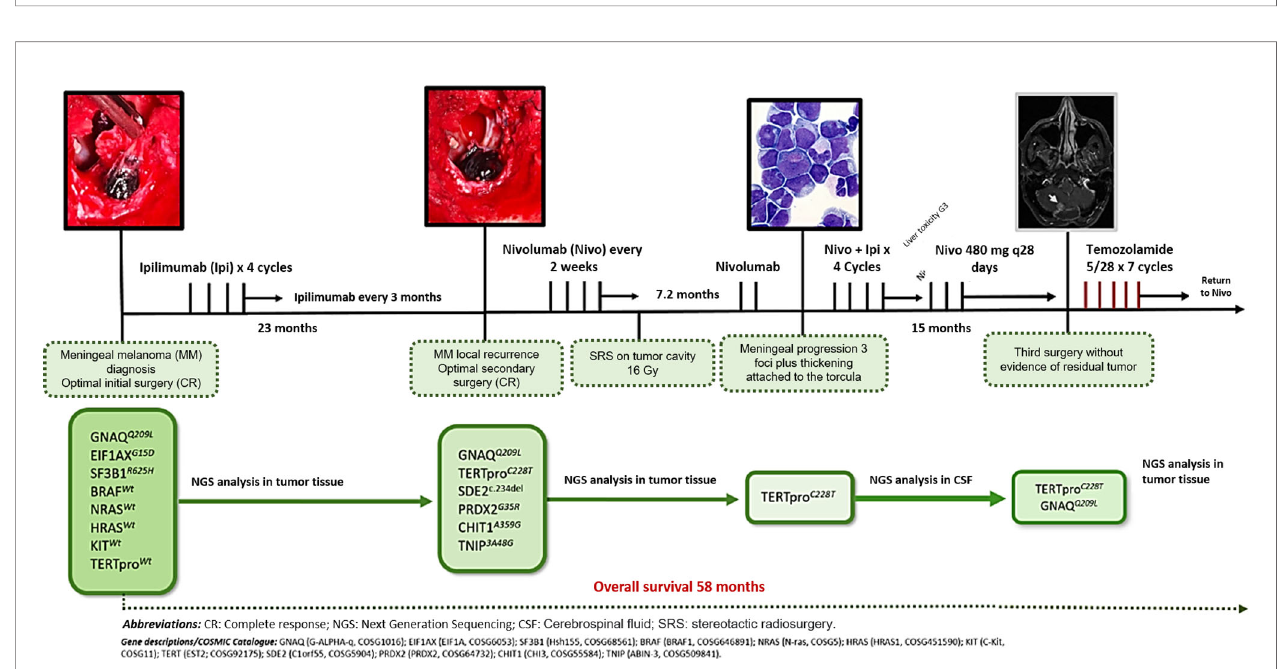
FIGURE 5 | Brain MRI scan after secondary resection. A similar low signal nodule in the surgical cavity is depicted [arrow in (A) , T2WI]. According to new onset of cephalalgia, the torcula ’ s extrinsic compression was demonstrated [double arrowhead in (B) , venous-phase angio-MRI]. In (C) (postcontrast T1WI), meningeal and surgical cavity enhancement is also noted